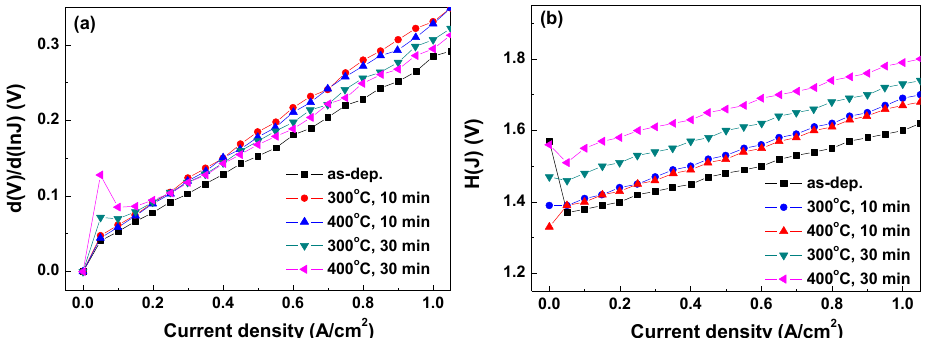
Figure 4. Plots calculated by the Cheung and Cheung method equation for Mo / SiC Schottky contacts: ( a ) d V / d(ln J ) vs. J ; ( b ) H ( J ) vs. J .